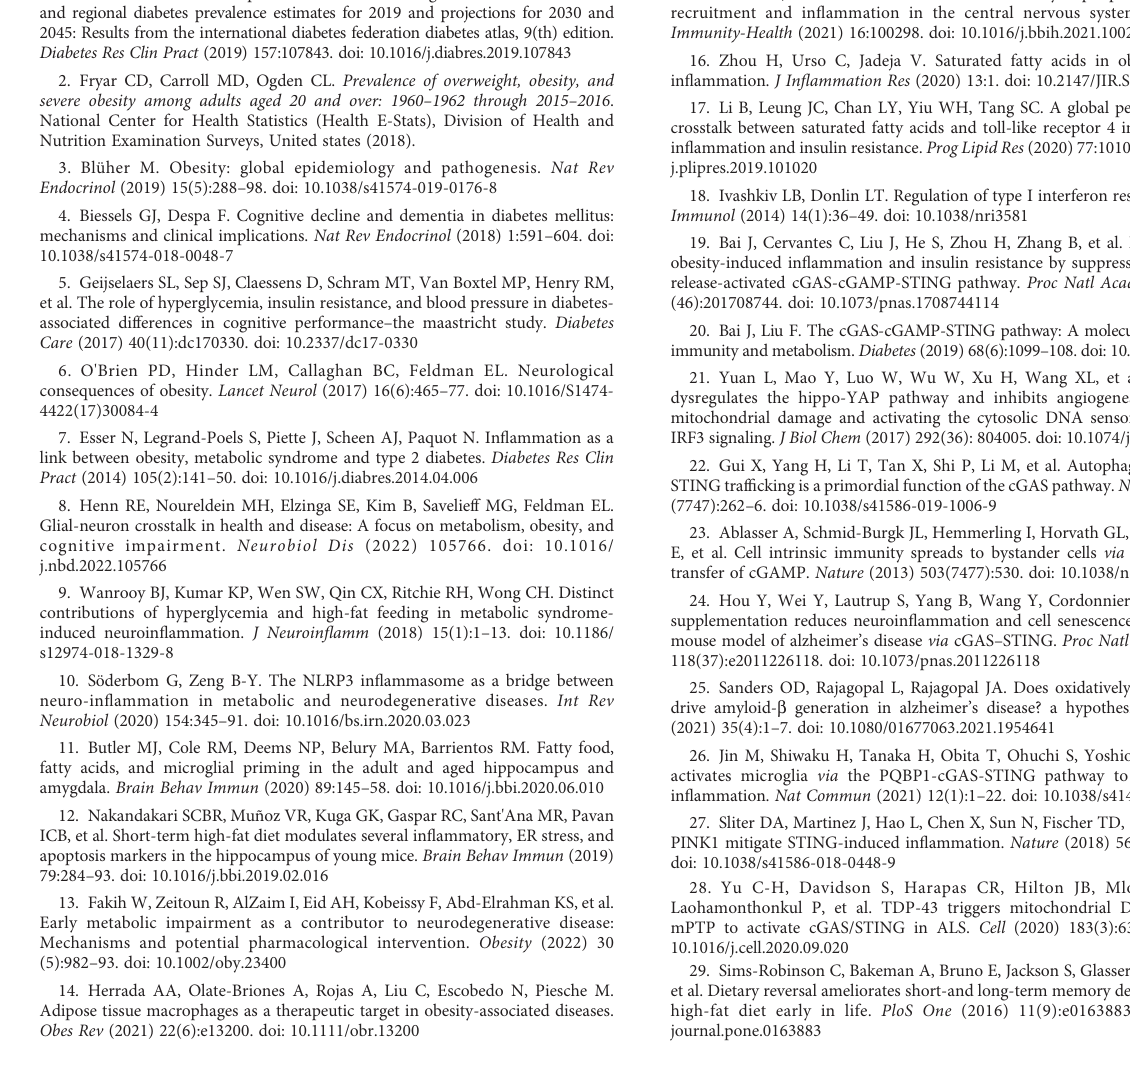
SUPPLEMENTARY FIGURE 9 Representative neuron and microglia cGAS/STING western blot images. Representative unaltered images of western blots quanti fi ed in main fi gure 6 (w/link color) for cGAS/STING pathway protein expression of cGAS (A) ,STING (B) , pIRF3 (C) , NF kb (D) , andtubulin (F) inpalmitate (Palm) and insulin (Ins) stimulated neuronal and microglial cell lines. Conditions in bold are those used for analysis.